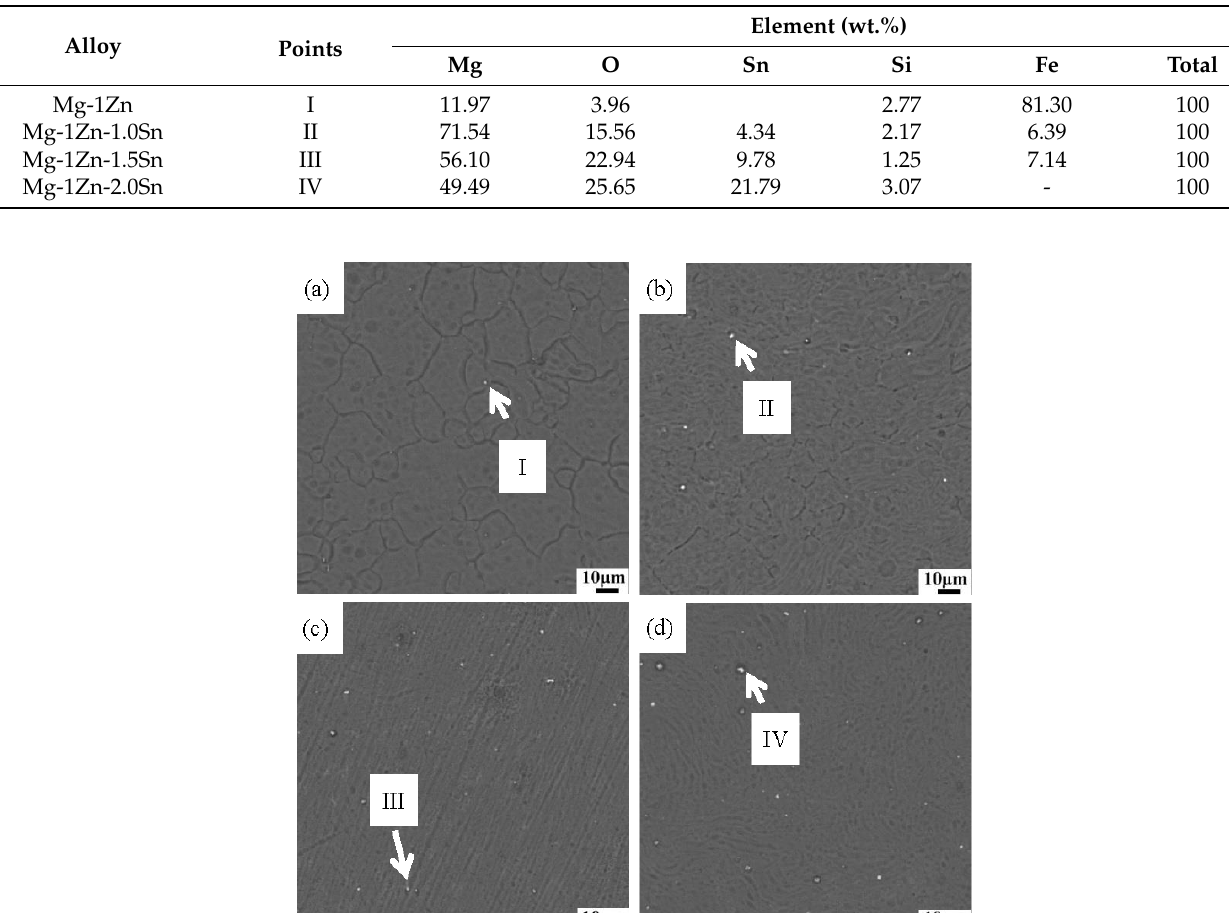
Table 1. Chemical compositions of the white particles in Mg–1Zn-based alloys (wt.%).